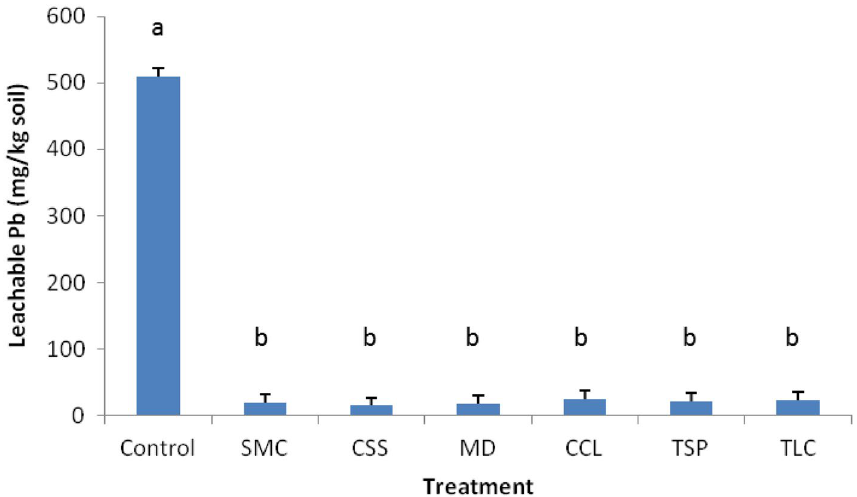
Figure 5. Average of leachable Pb in the amendment-treated and untreated (control) mining wastes during the 8–10 year sampling period post treatment. Vertical bars indicate the standard deviation of measurements, and different letters denote significant difference ( p < 0.05) among treatments.